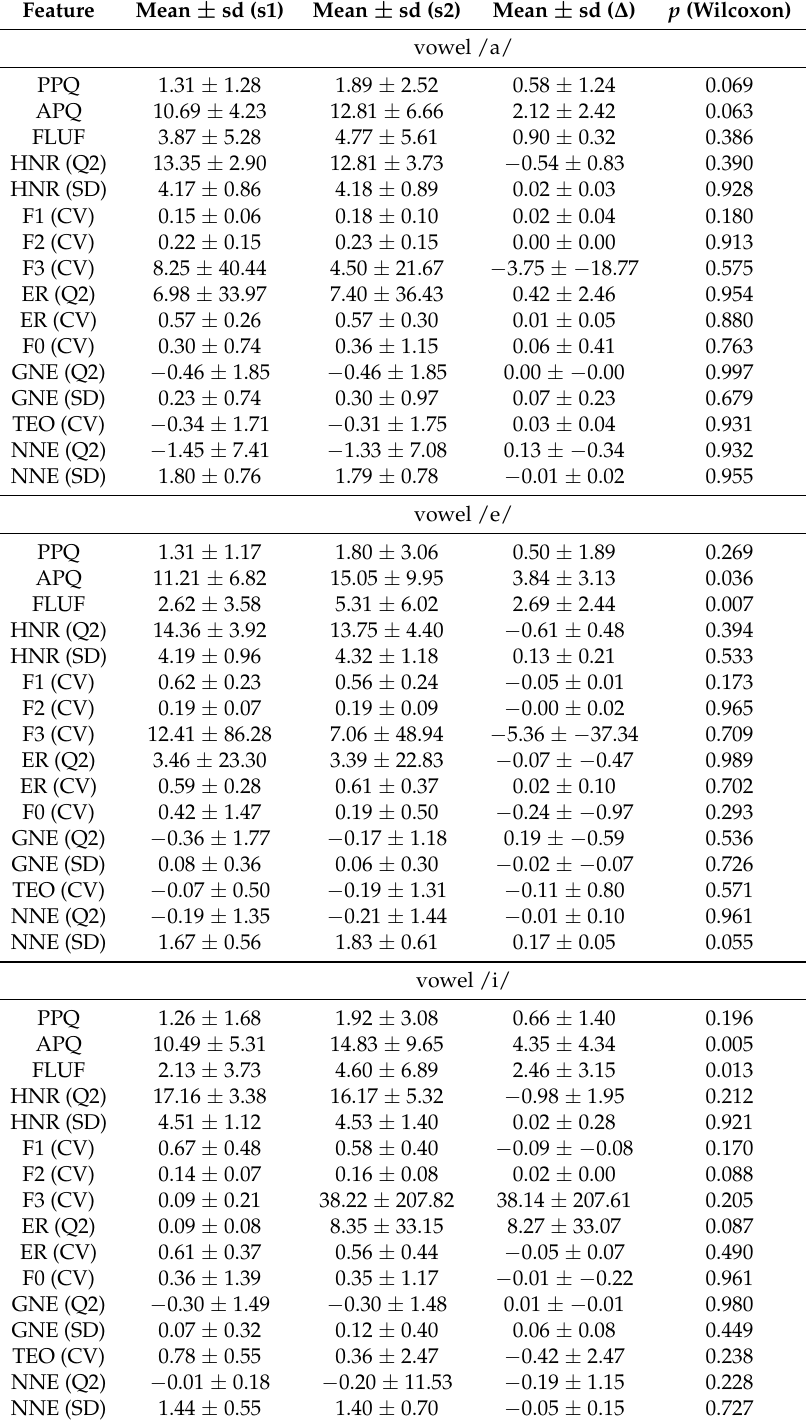
Table 2. Statistical description of acoustic features for all vocal